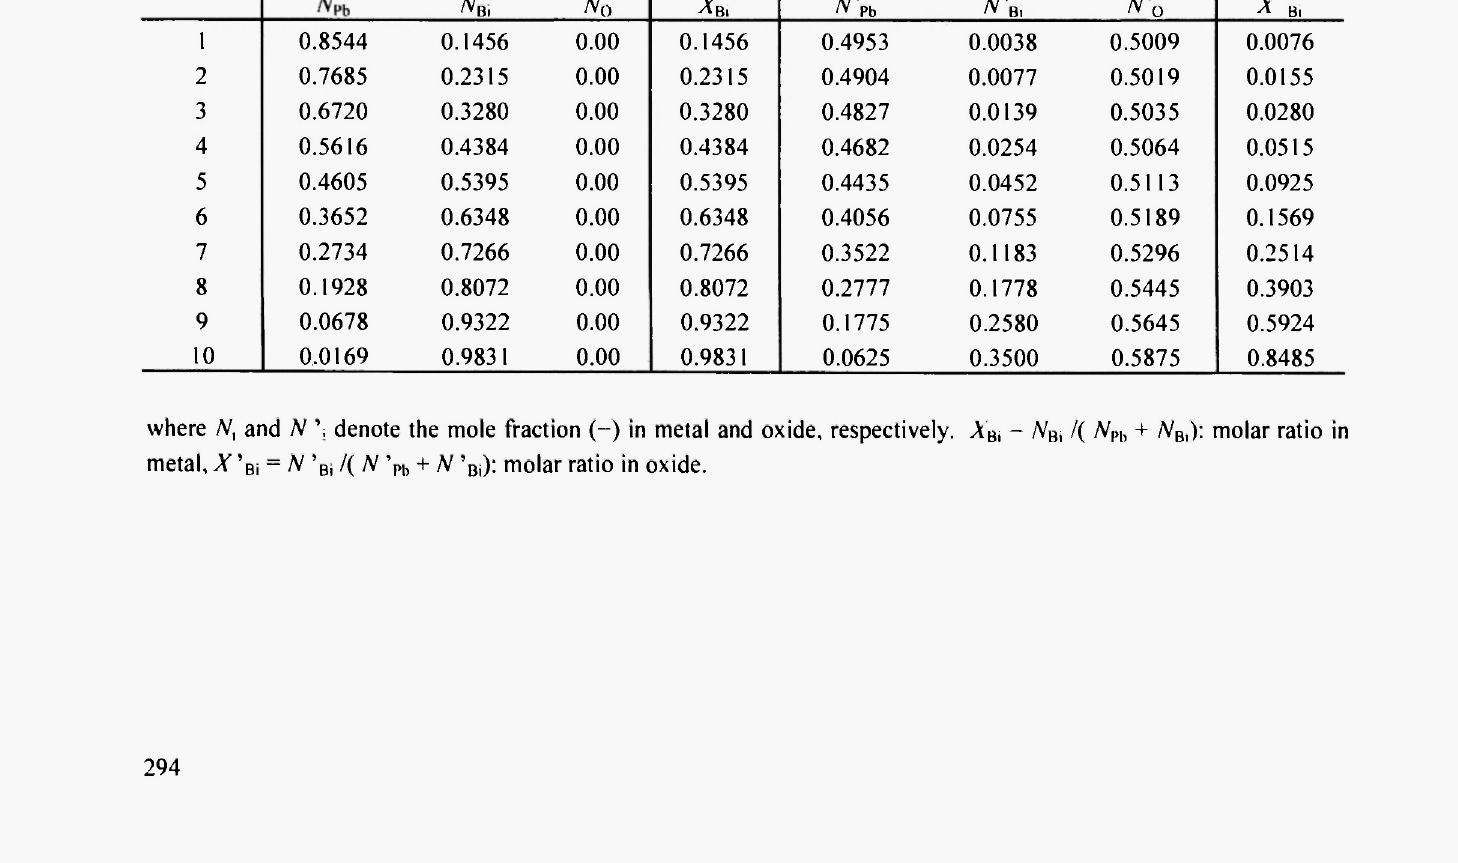
Results of atomic absorption spectrometry for the equilibrated samples at 1223 Κ in the lead-bismuth-oxygen system. Exp.